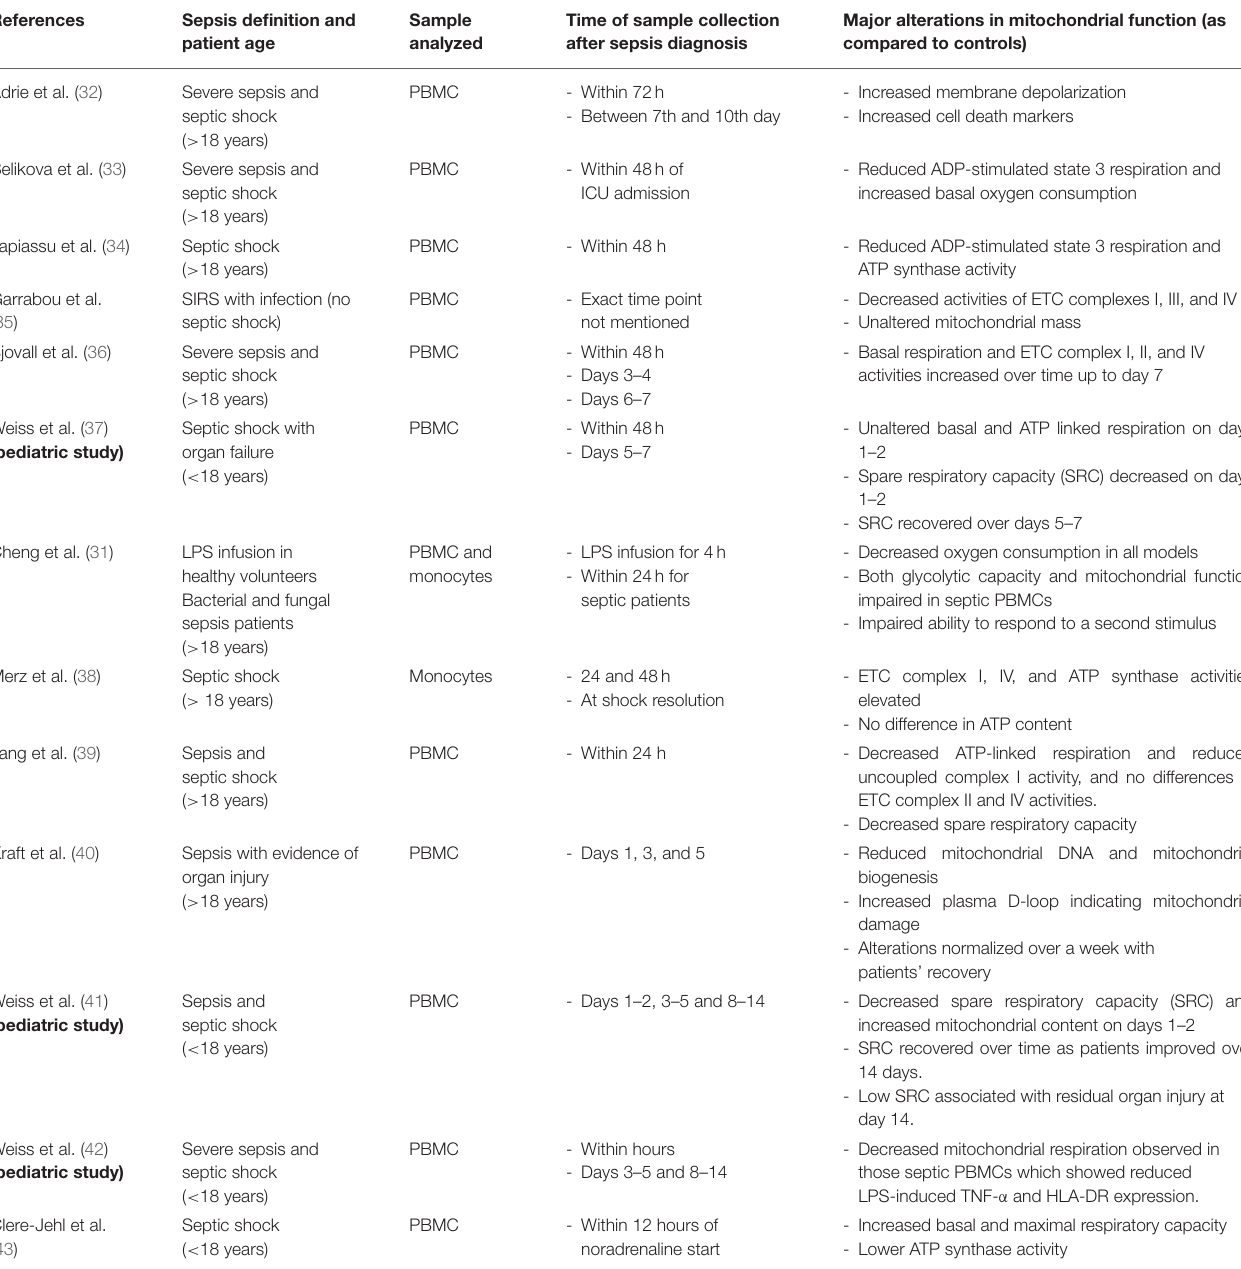
TABLE 1 | Summary of clinical studies showing sepsis-induced alterations in leukocyte mitochondrial